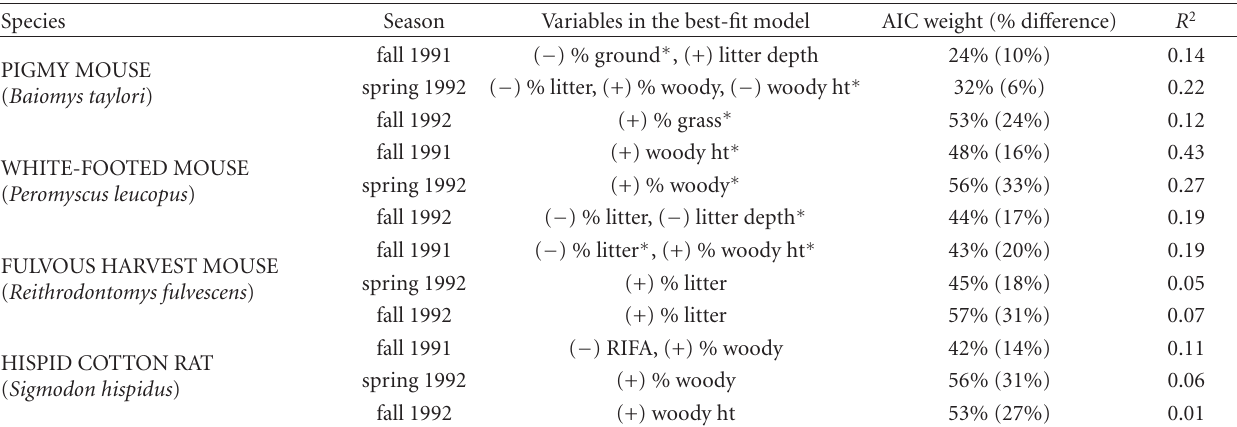
Table 2: Results of the best-fit spatial multiple linear regressions relating small mammal captures to average red imported fire ant (RIFA) foraging activity and five microscale habitat characteristics. Asterisks indicate significant explanatory variable in the best fitting model. We report AIC weight and % di ff erence in AIC weights between the best-fit model (reported) and its most likely alternative